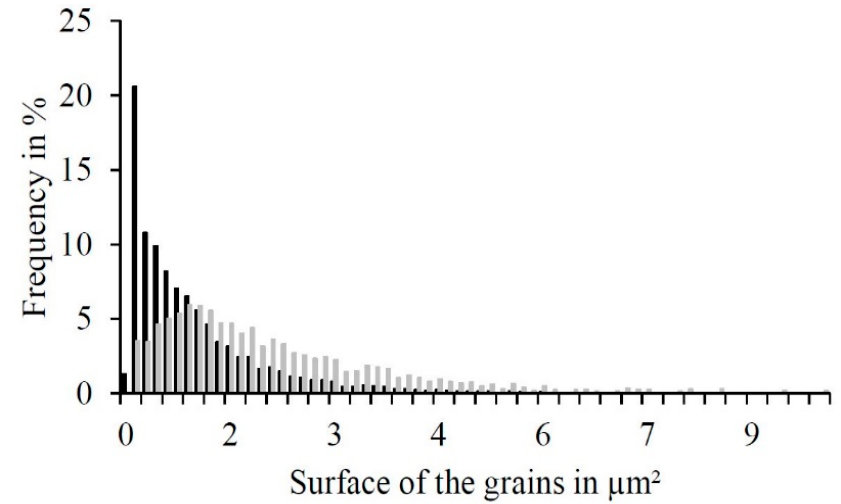
Figure 5. Histogram of the area-based grain size of PBF-LB-generated WE43 of the spherical grains ( gray ) and longitudinal grains ( black ).